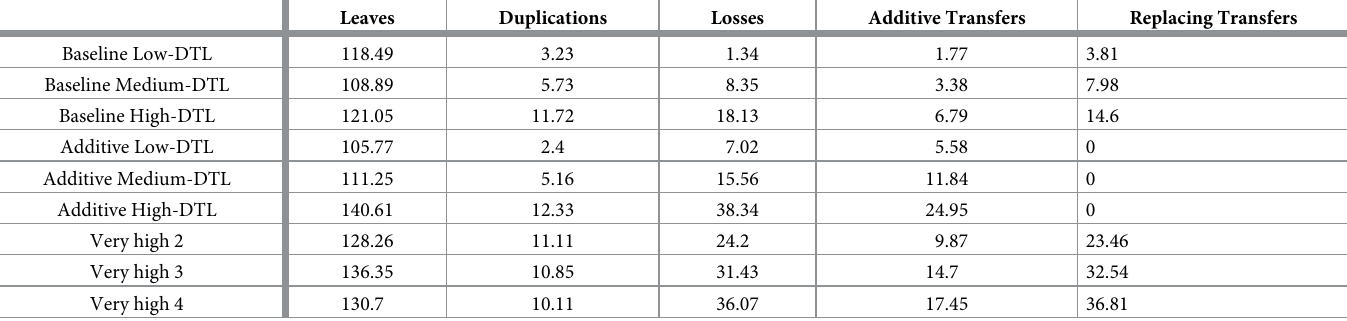
Table 1. Simulated data sets. This tables shows the average numbers of leaves, duplication events, losses, additive transfer events, and replacing transfer events in the vari- ous baseline, additive, and very high transfer rate data sets. Results are averaged across the 100 gene trees in each set. Leaves Losses